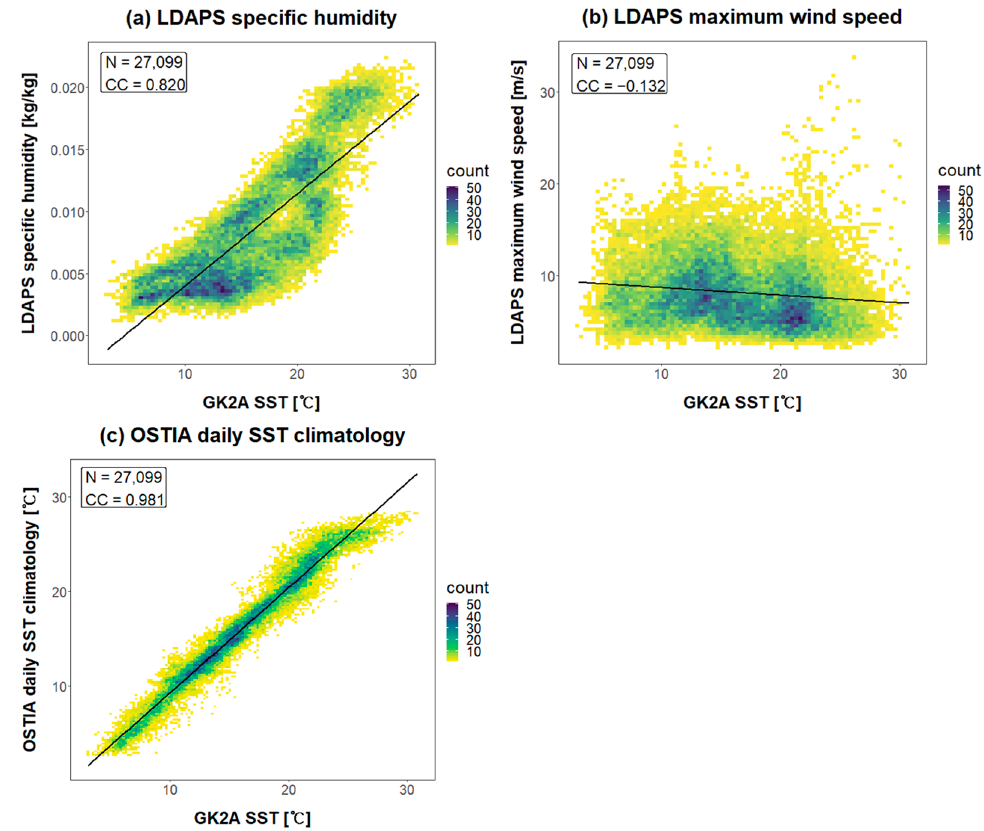
Figure 7. Scatter plot of the relationships between GK2A SST and ( a ) LDAPS specific humidity, ( b ) LDAPS maximum wind speed, and ( c ) OSTIA daily SST climatology value. 27,099 pixels were matched to the in situ measurement points in 2020.